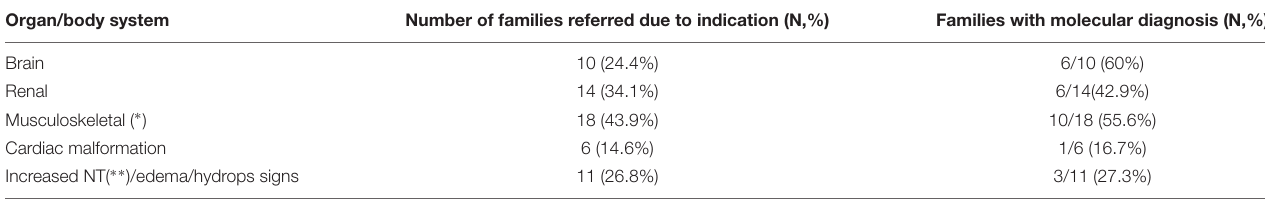
TABLE 3 | Referral indications and WES yield, according to US findings in specific organ or body systems (among 41 families with US